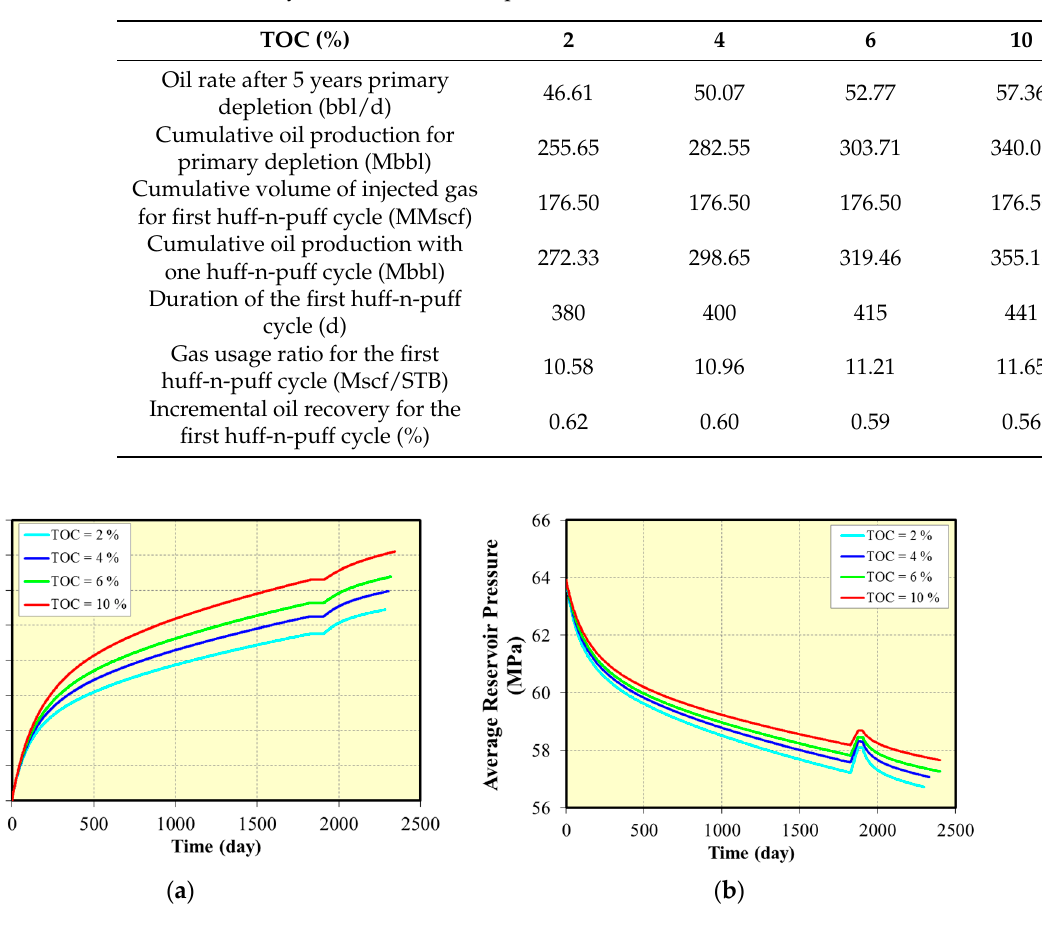
Figure 6. Effect of different TOC with one huff-n-puff cycle on oil production and reservoir pressure: ( a ) Cumulative oil production for different TOC; ( b ) Average reservoir pressure for different TOC.